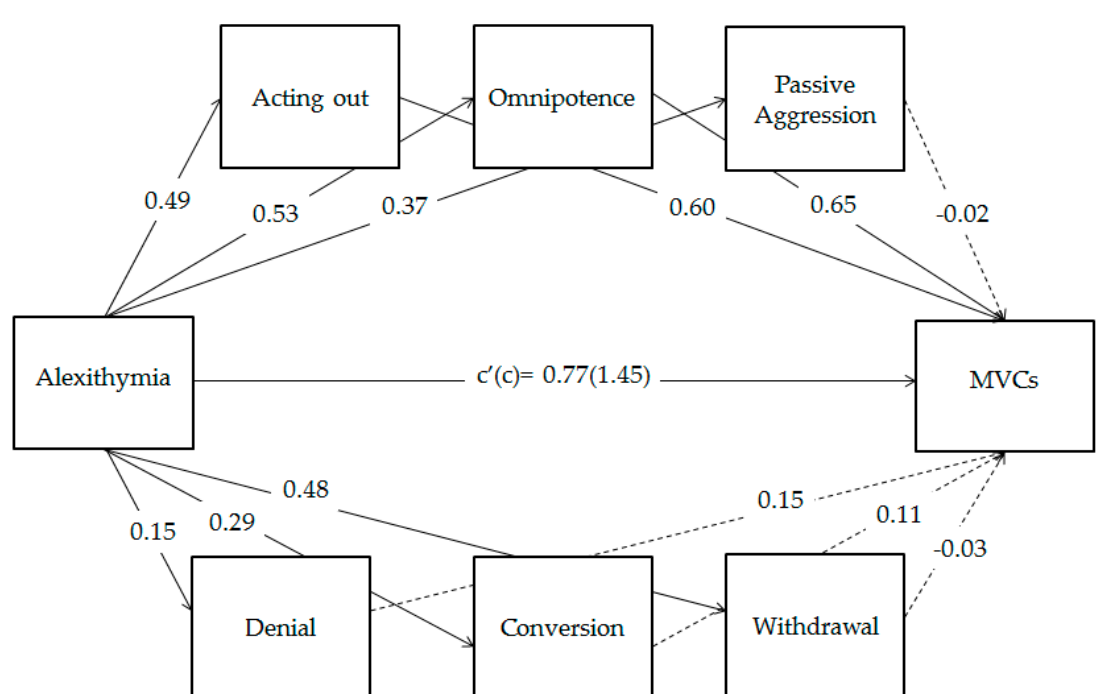
Figure 2. Parallel mediation of adolescents’ defense strategies use on the relationship between alexithymia and the frequency of motor vehicle collisions (MVCs). Coefficients shown are standardized path coefficients. Dotted lines represent non-significant parameters. c’ = direct effect; c = total effect.